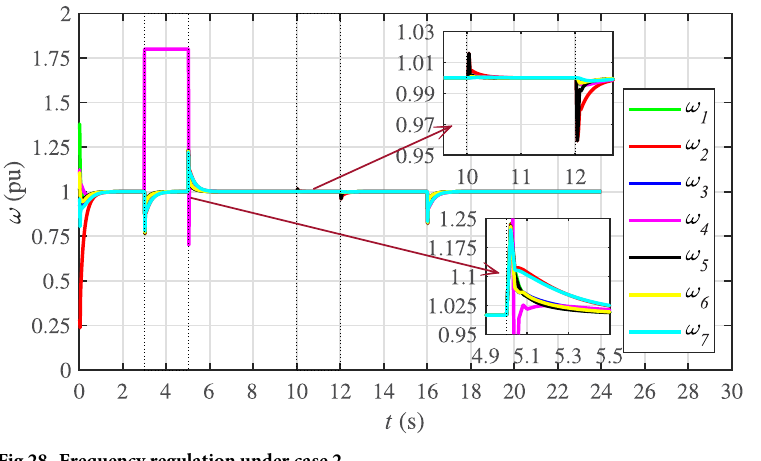
Fig 28. Frequency regulation under case 2.